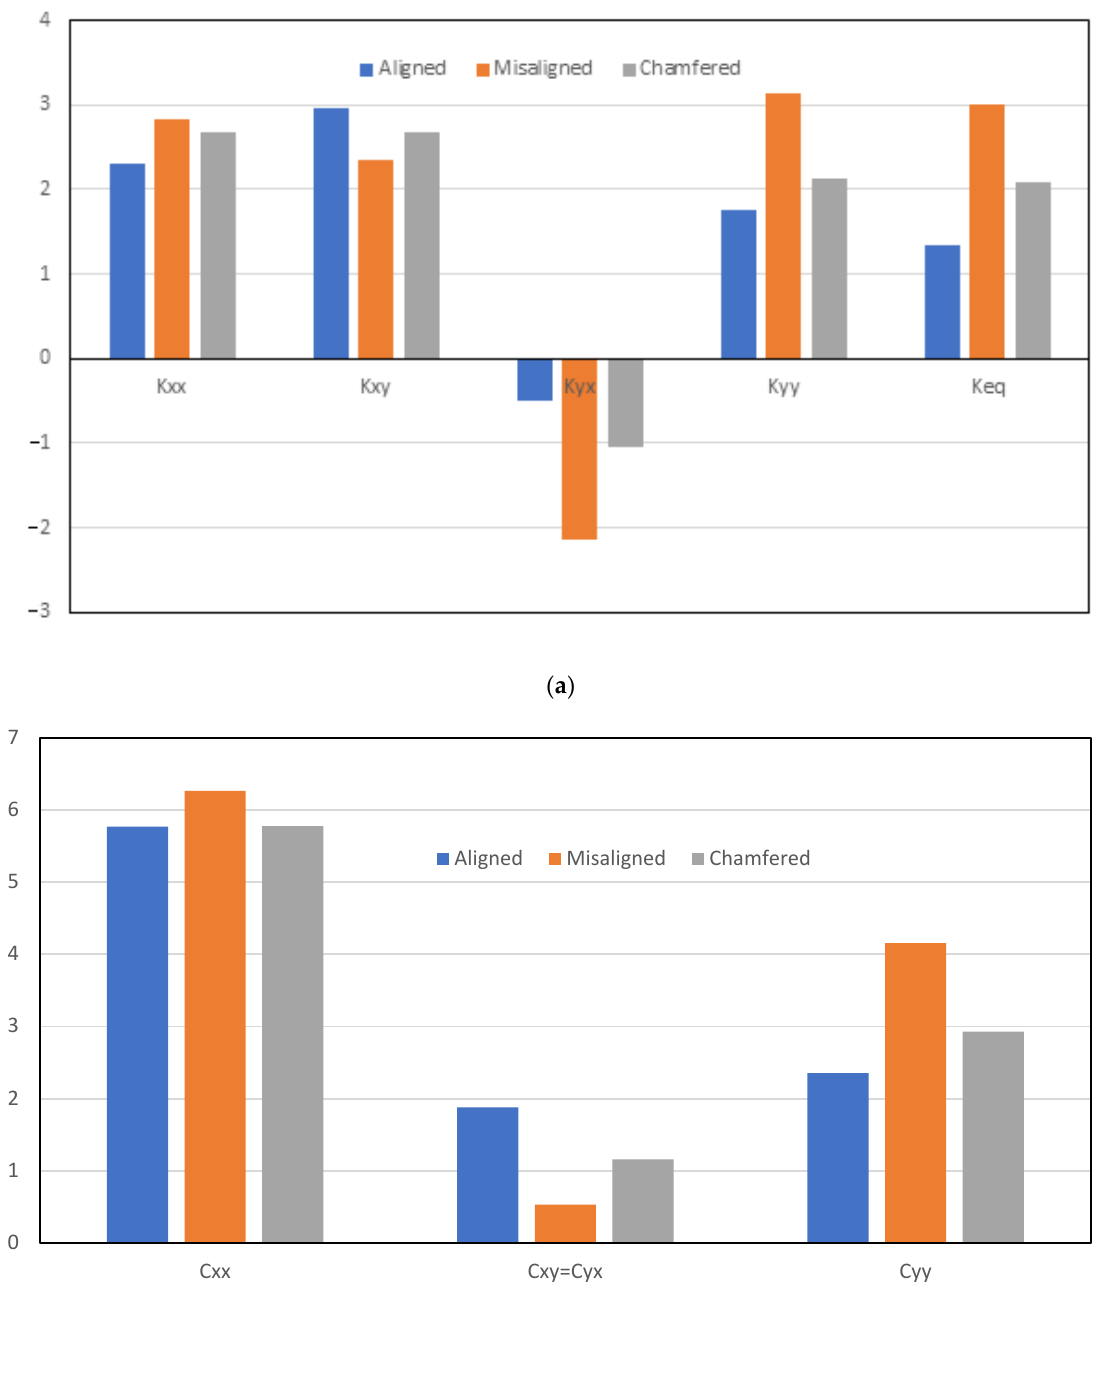
Figure 7. Effect of chamfer parameter A on the dimensionless ( a ) critical speed and Pmax and ( b ) critical speed and Hmin. (B = 0.25, L/D = 1.25, ∆ℎ (cid:3042) (cid:3404) ∆𝑣 (cid:3042) (cid:3404) 0.58, and 𝜀 (cid:3045) (cid:3404) 0.6 ).